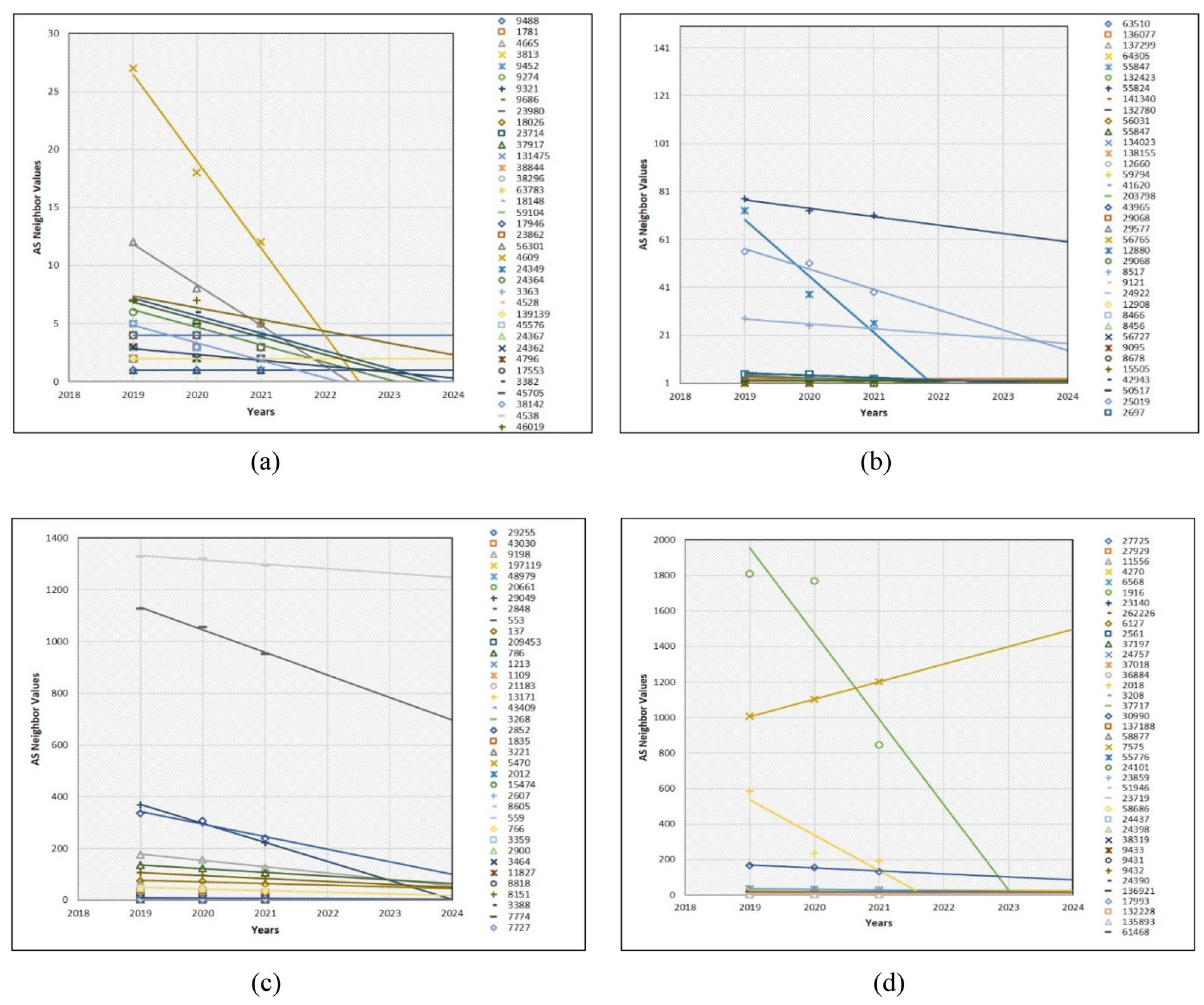
Figure 7. Prediction of 150 university type AS neighbor values.